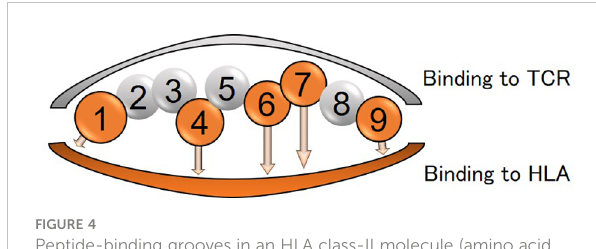
FIGURE 4 Peptide-binding grooves in an HLA class-II molecule (amino acid position 1-9) are shown. Amino acids in positions 1, 4, 6, 7, and 9 bind to HLA and those in positions 2, 3, 5, and 8 are assumed to be outward facing in order to stimulate the T-cell receptor